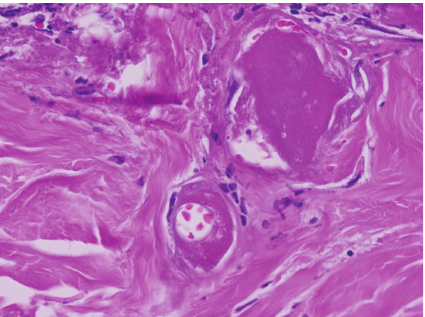
Figure 4: Hematoxylin and eosin. 40X. Superficial dermal telang- iectasia with fibrin thrombi and